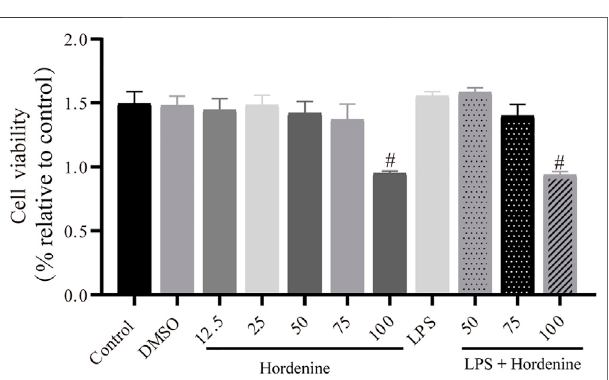
FIGURE 4 | Effects of different concentrations of hordenine base with or without LPS on the viability of RAW264.7 cells. RAW264.7 cells were pre- treated with hordenine for 1 h and stimulated with LPS for 2 h. Cell viability was determined using the Cell Counting Kit-8 assay. Results are shown as means ± SD ( n (cid:1) 3). # p < 0.01 vs. control group. LPS: lipopolysaccharide; DMSO: dimethyl sulfoxide.